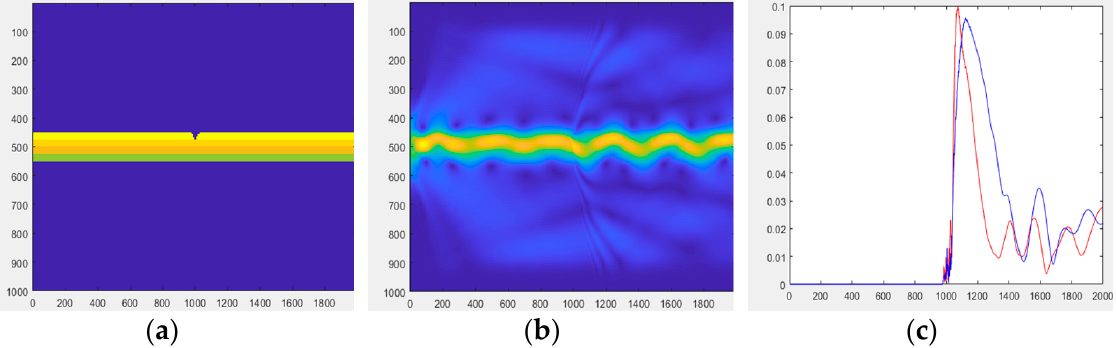
Figure 10. ( a ) Deformed optical waveguide viewed from the side. ( b ) Scattering inside the optical waveguide due to waveguide deformation. ( c ) Optical waveguide.